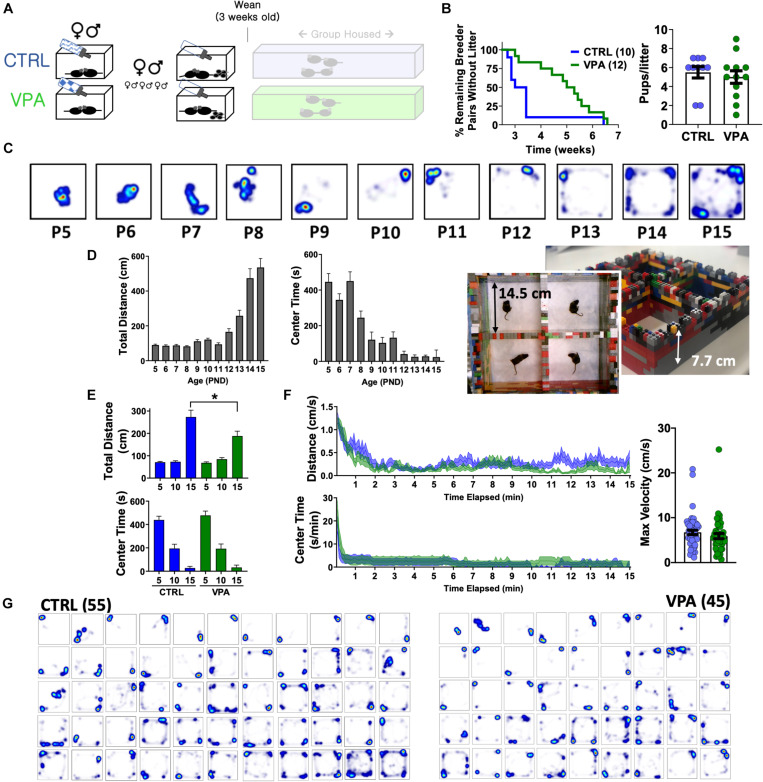
Pup open field behavior following prenatal VPA exposure. (A) Breeder pairs were exposed to VPA or control solutions until parturition. (B) VPA-exposed breeder pairs took longer to produce a viable litter (p < 0.05, Mantel-Cox log-rank test), without a change in litter size. (C) Representative heat maps of position probability from a separate cohort of C57BL/6J mice (n = 27—45/group), illustrating progressive changes in open field exploration. (D) Distances and center times for C57BL/6J mice. (E) Total distances and center times across CTRL and VPA cohorts, and (F) time-dependent changes in behavior at P15. (G) Heat maps of position probability for all pups studied at P15 ranked by overall cage exploration (CTRL n = 55 (32 female), VPA n = 45 (21 female)]. Mean + SEM shown for all. CTRL, control; VPA, valproic acid. P15 = post-natal day 15. ∗p < 0.05.